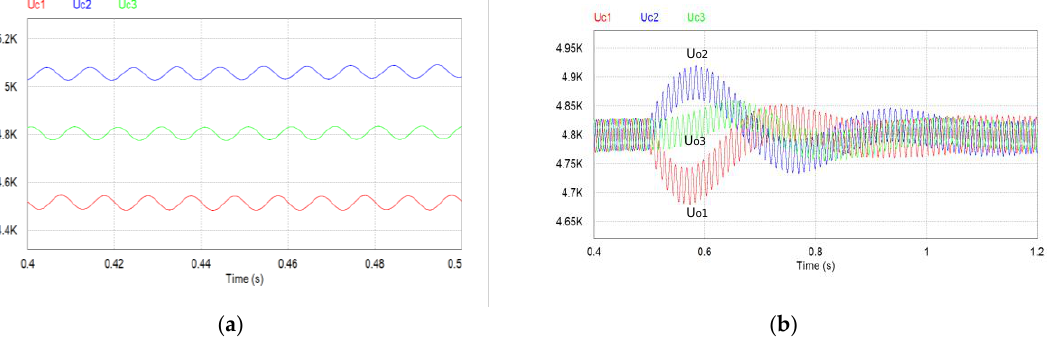
Figure 10. The dc-link voltages simulation waveforms in unbalanced loads. ( a ) no zero sequence current injection. ( b ) after the zero sequence current injection.